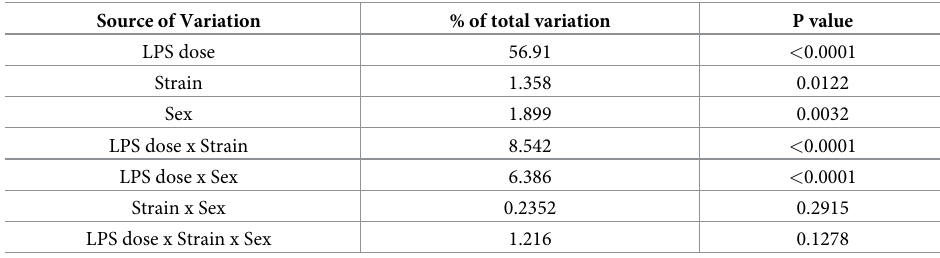
Table 2. Three-way ANOVA analysis of brain/serum ratios of 99m